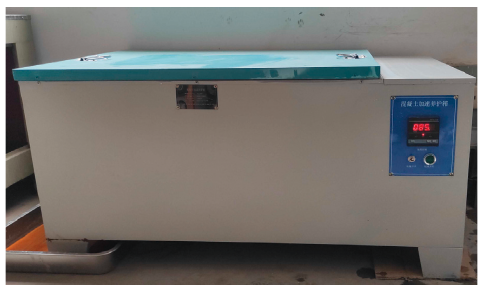
Figure 2: Water tank with a constant temperature. Table 3: The flexural and compressive strength.